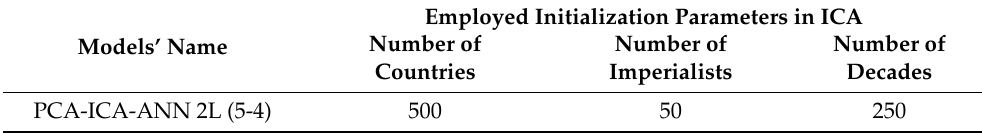
Table 12. Characteristics of the imperialist competitive algorithm in the ANN